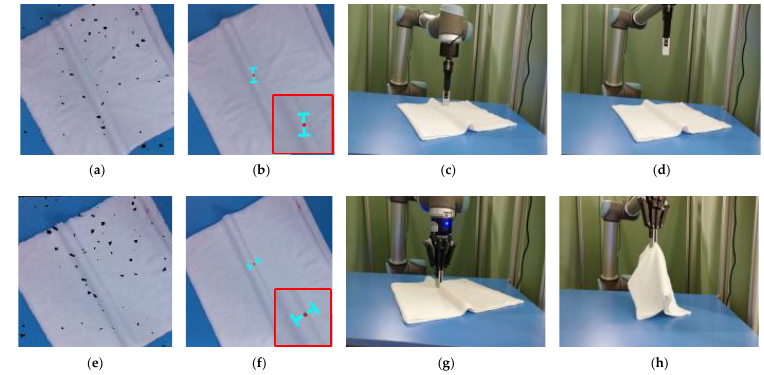
Figure 7. The comparison of good and bad grasp directions: ( a ) the point clouds of a white towel on a table; ( b ) the projection of a inappropriate grasp pose on the image; ( c ) the robotic arm reaches the grasp position; ( d ) the robotic arm picks empty; ( e ) the point clouds of a white towel on a table; ( f ) the projection of a appropriate grasp pose on the image; ( g ) the robotic arm reaches the grasp position; ( h ) the robotic arm picks a